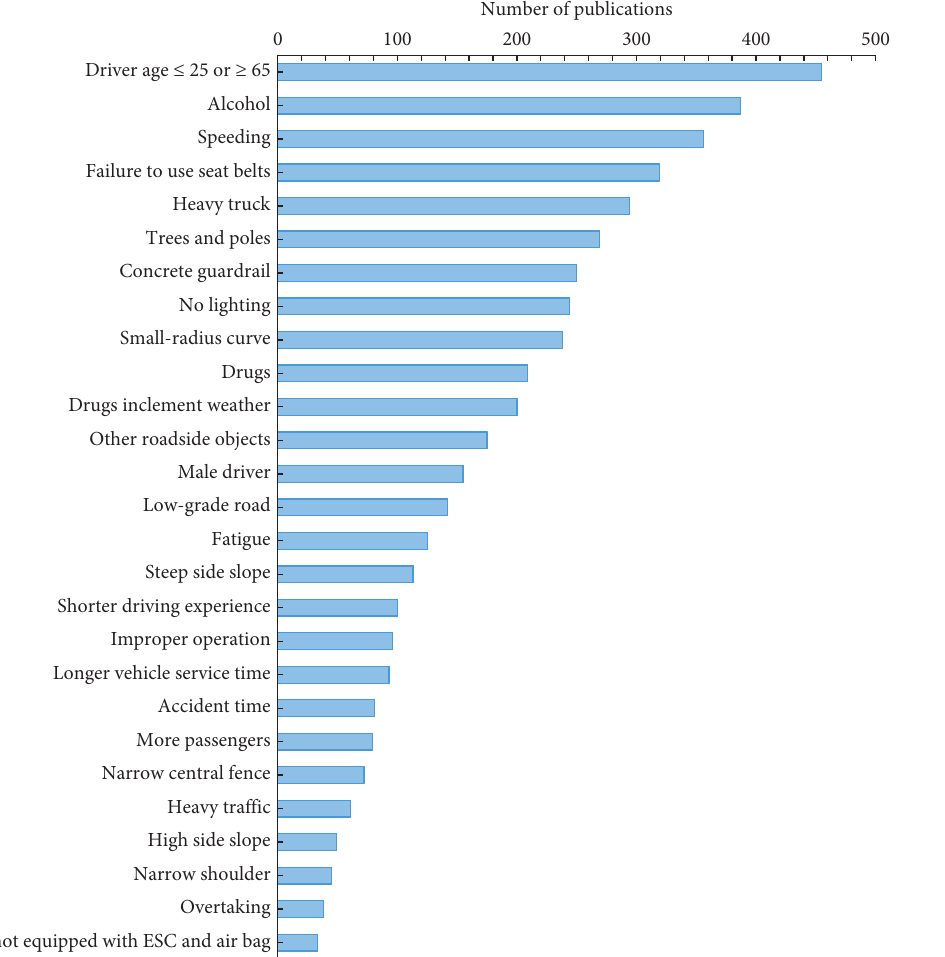
Figure 5: Risk factors for severity of roadside